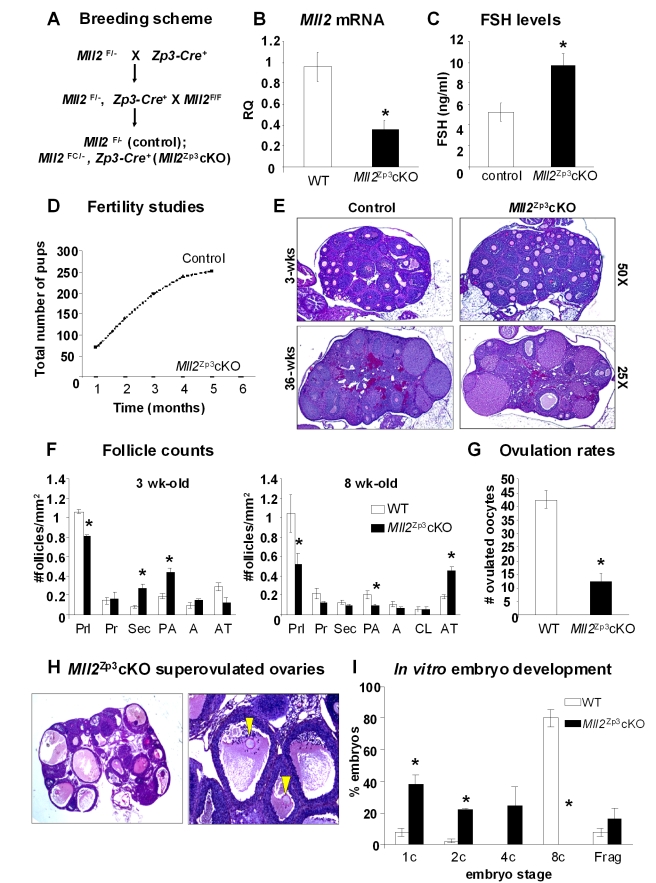
Oocyte-specific deletion of Mll2 mediated by the Zp3-Cre allele.(A) Breeding scheme used to generate Mll2Zp3cKO mice. (B) Zp3-cKO oocytes show a significant reduction in Mll2 mRNA levels (Student's t test, * p<0.05). Results are shown as means ± S.E. relative to WT (RQ) (three oocyte pools were used; n = 3) and Gapdh was used as endogenous control. (C) FSH levels were significantly higher in serum samples from 8-wk-old Mll2Zp3 cKO females compared to controls (Student's t test, * p<0.05; n = 10). (D) Fertility studies shown as cumulative number of pups over a 6-mo period. Mll2Zp3cKO females were infertile. (G) Ovulation rates were significantly reduced in Mll2Zp3cKO females compared to controls (WT) (Student's t test; * p<0.05; n = 5). (E) PAS-stained ovaries from 3- and 36-wk-old mice. Original magnification: 25× and 50×; note that different from Mll2Gdf9 cKO mice, Mll2Zp3 cKO ovaries still contain follicles at 36 wk of age. (F) Follicle counts in Mll2Zp3 cKO ovaries. Mll2Zp3 cKO ovaries had a significantly lower number of primordial follicles and increased numbers of secondary and multilayer preantral follicles 3 wk of age (left panel). By 8 wk of age (right panel), the number of primordial and multilayer preantral follicles is significantly reduced and the number of atretic follicles is increased in Mll2Zp3 cKO ovaries. (ANOVA test; * p<0.05; ovarian sections from five females were used in the analysis; n = 5). Abbreviations: Prl, primordial; Pr, primary; Sec, secondary; PA, preantral; A, antral; CL, corpora lutea; Atr, atretic. (I) Cultures of embryos from Mll2Zp3 cKO females crossed to WT males showed a developmental arrest between the 1-cell and the 4-cell stages. Results are presented as the % embryos (average) ± standard error from five independent experiments. ANOVA test; * p<0.05. A total of 95 embryos from six females per genotype were used in three independent experiments. Abbreviations: C, cell; Frag, fragmented; WT, control wild type.